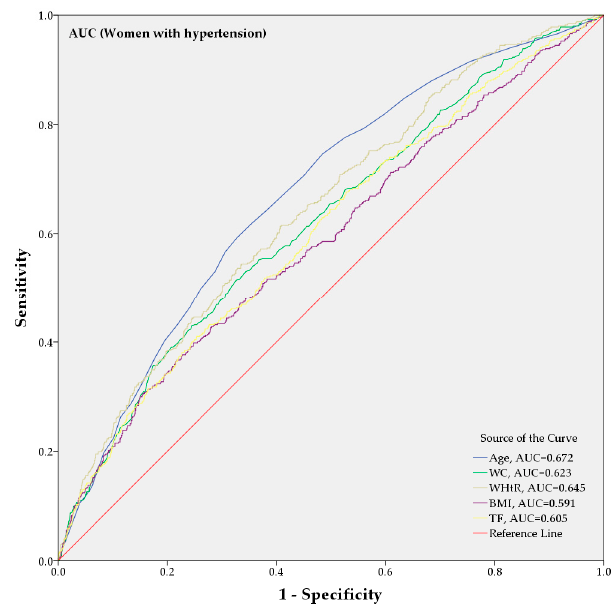
Figure 4. Area under the curve (AUC) analysis of hypertension based on anthropometrics and body composition in women.